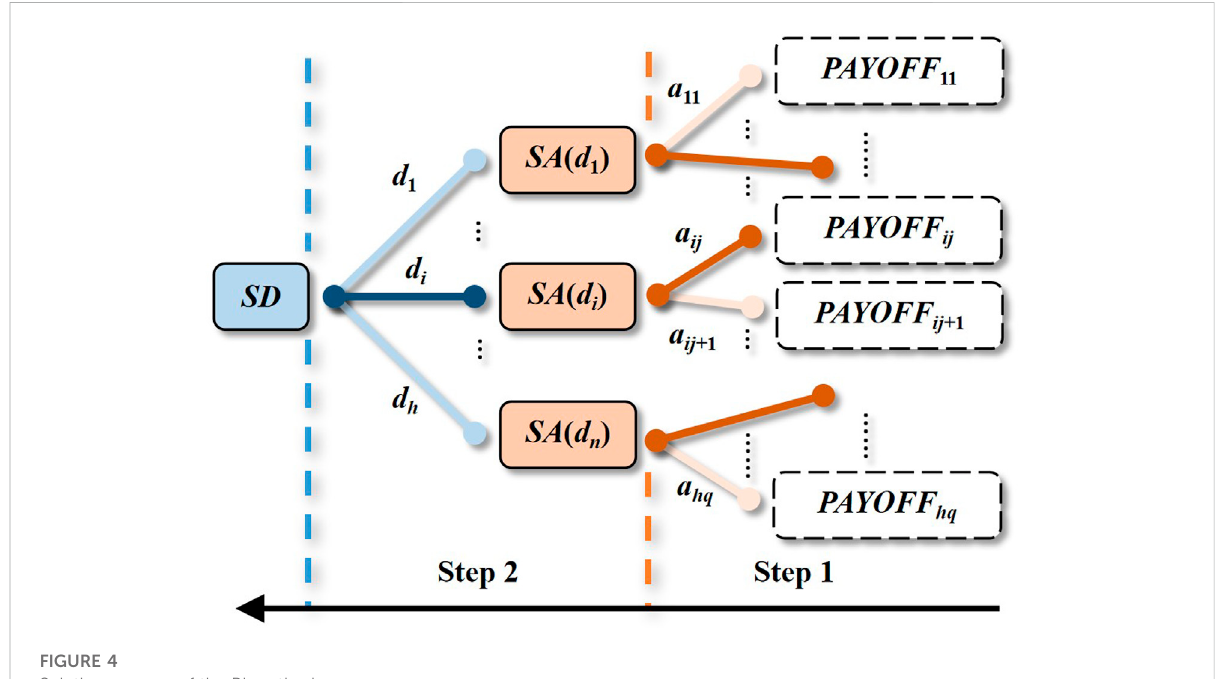
FIGURE 4 Solution process of the BI